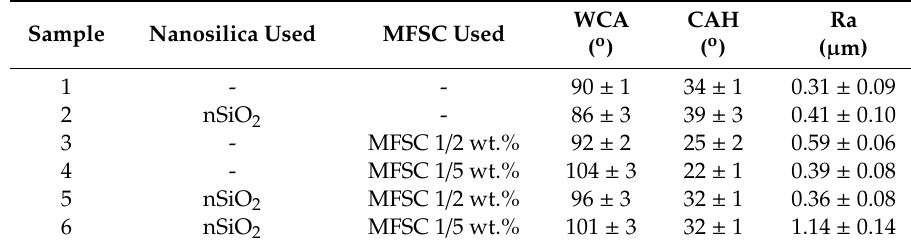
Table 2. Description and roughness of the samples with multi-functionalized organosilicon compound (MFSC) 1.